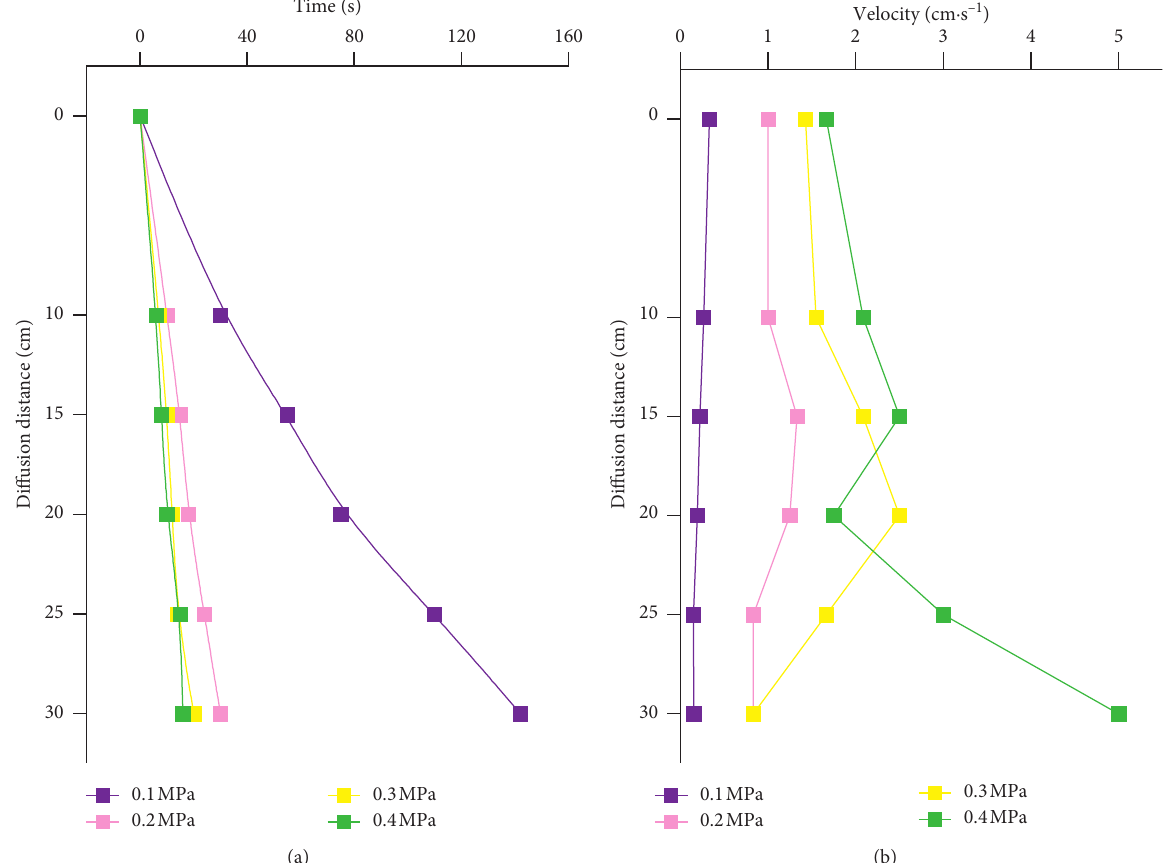
Figure 5: The law of grouting diffusion in soil. (a) The relationship between time and diffusion distance. (b) The relationship between velocity and diffusion distance.